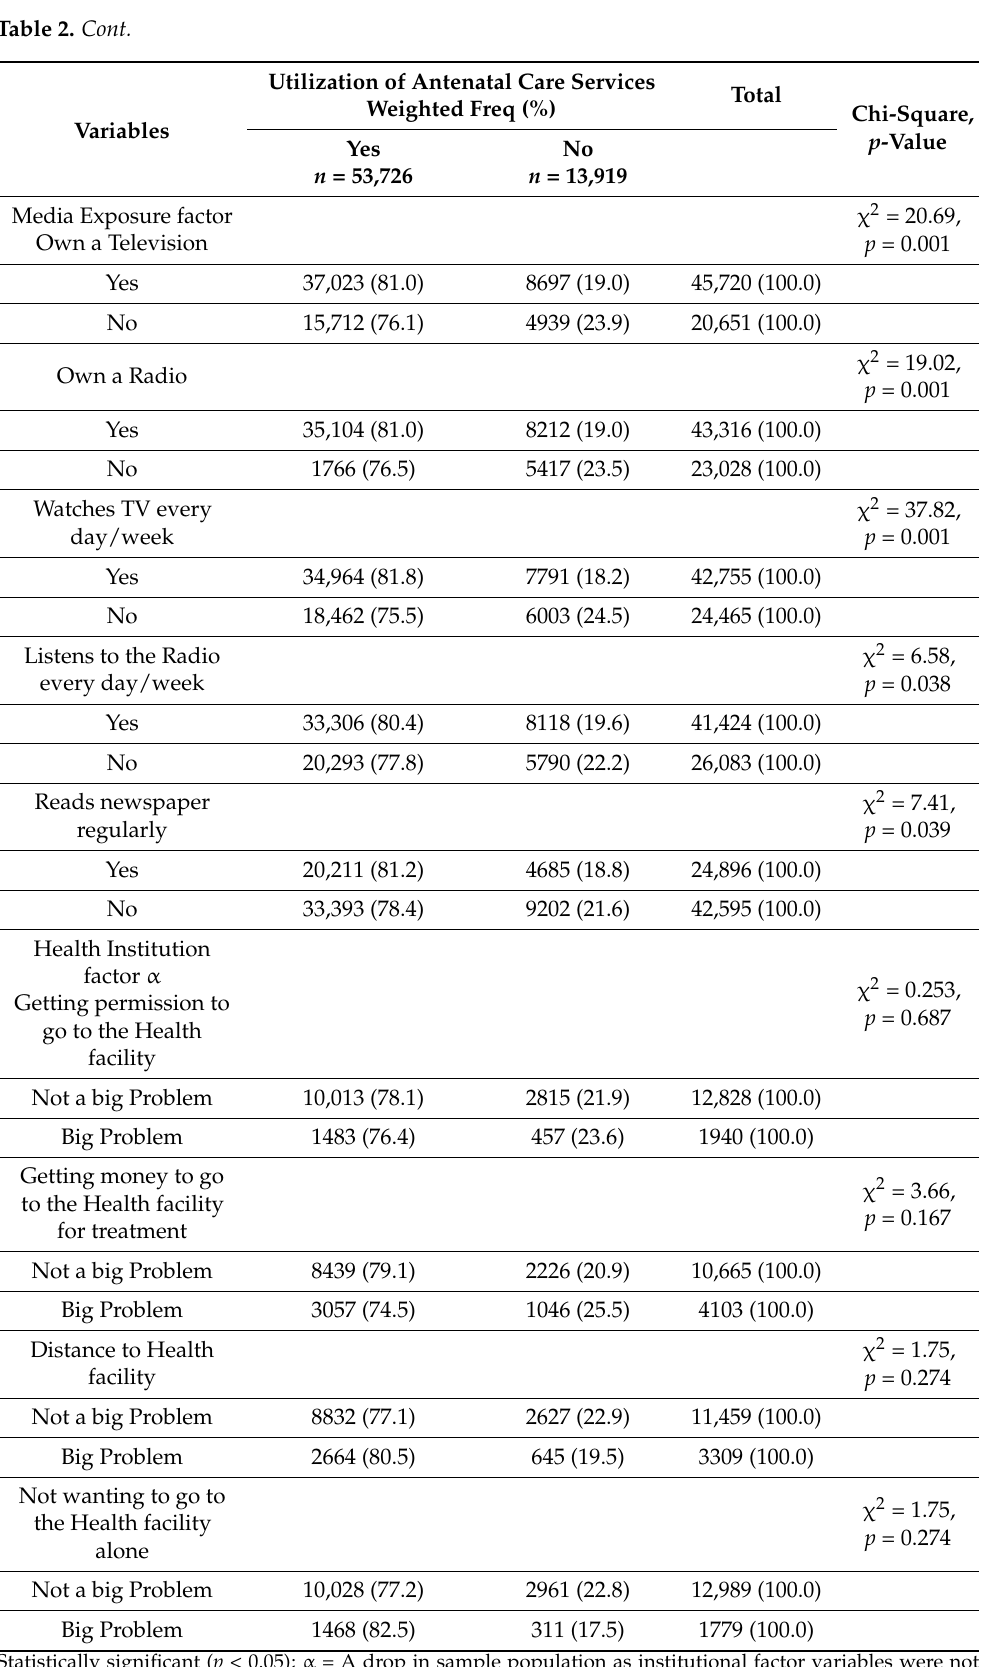
Table 2. Cont. Utilization of Antenatal Care Services Variables